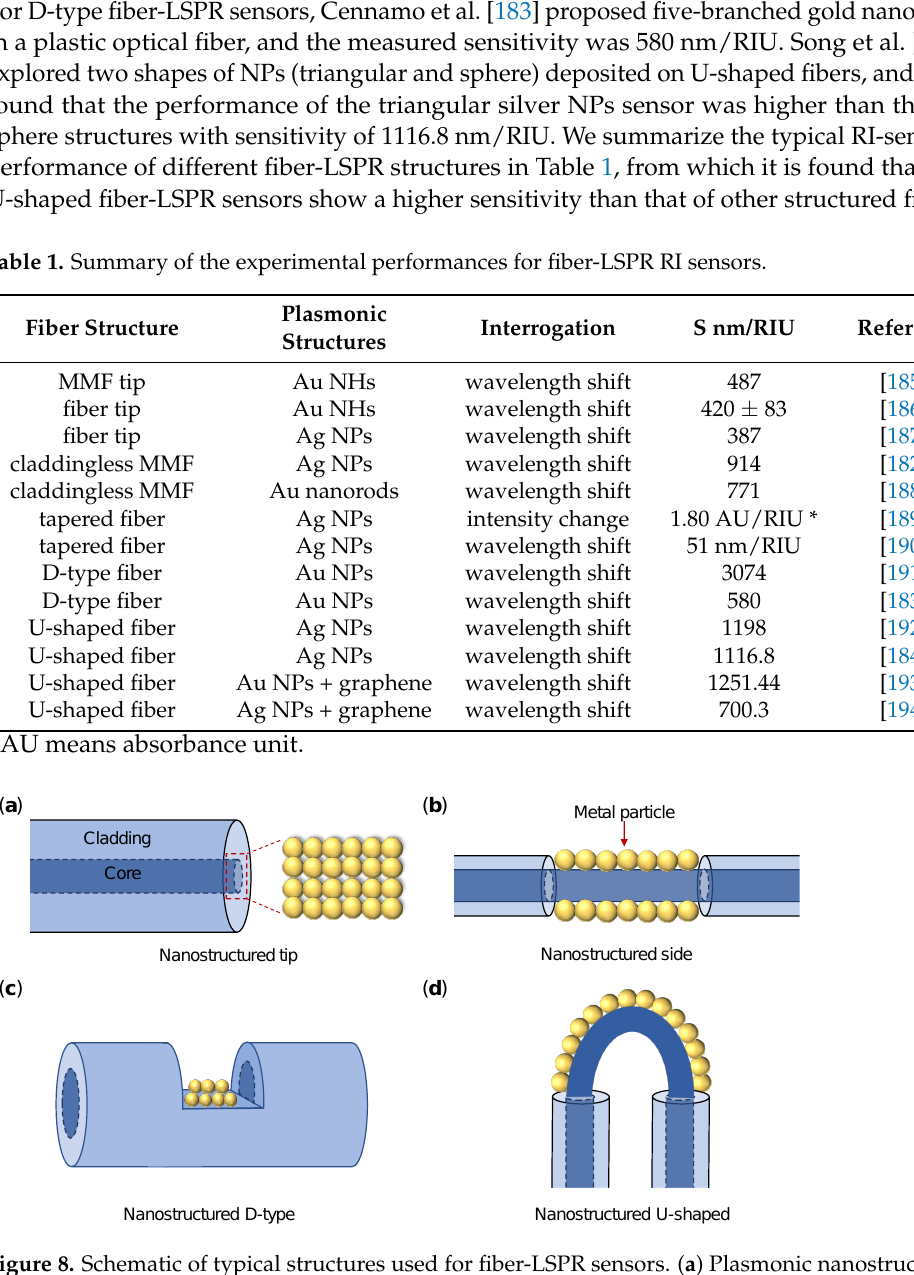
Figure 8. Schematic of typical structures used for fiber-LSPR sensors. ( a ) Plasmonic nanostructures on fiber tip, ( b ) Fiber side wall, ( c ) D-type fiber, ( d ) U-shaped